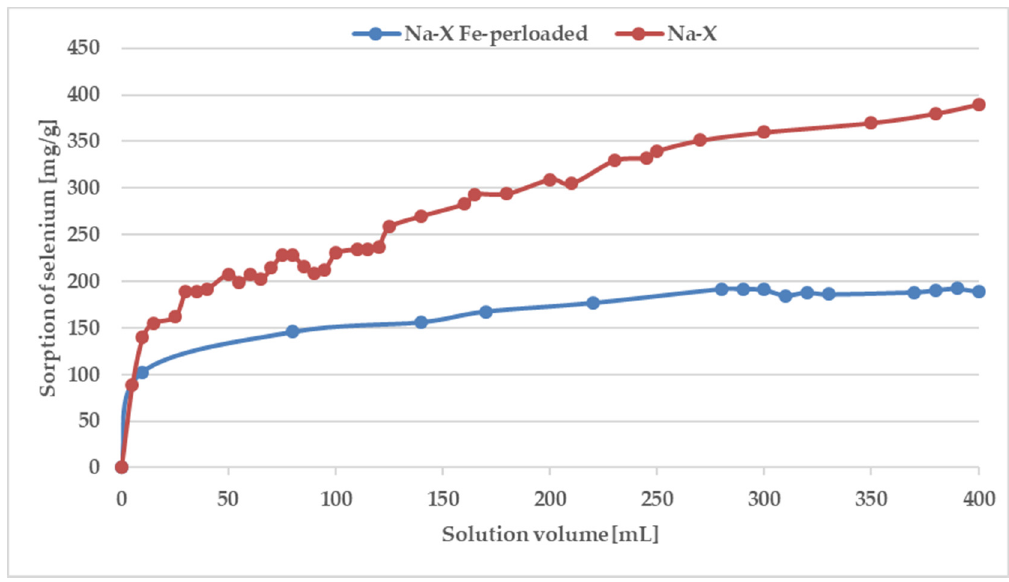
Figure 7. Breakthrough curves for selenium adsorption on Na-X and Na-X perloaded by iron.